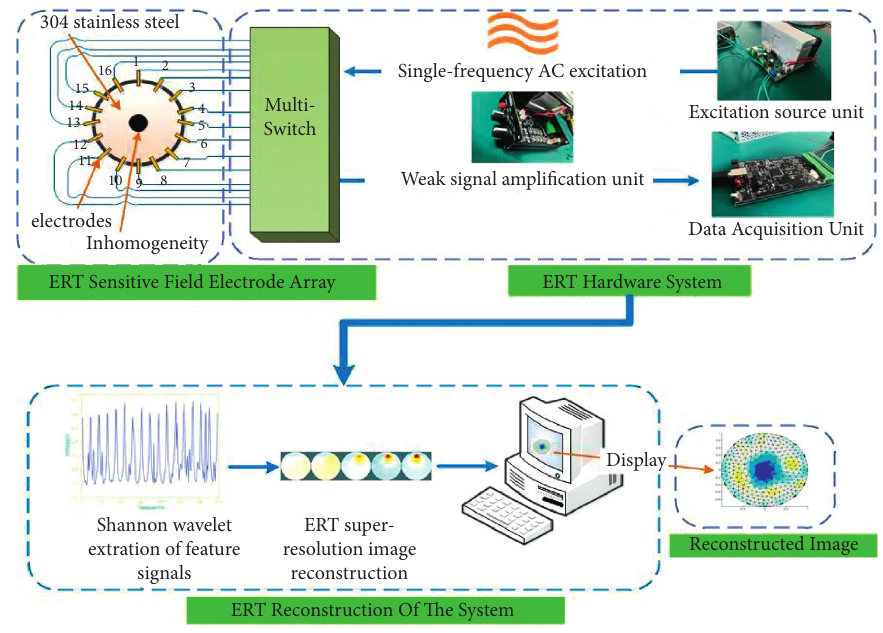
Figure 1: Block diagram of metal conductivity electrical resistance tomography system.